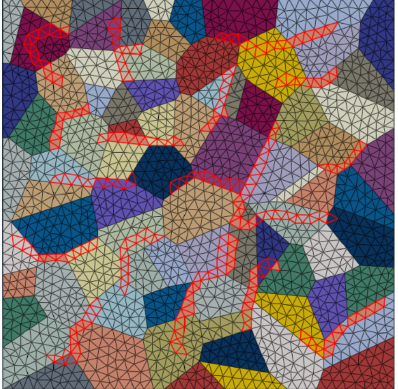
Figure 4. Model 2 : Synthetic grain structure with embedded graphite